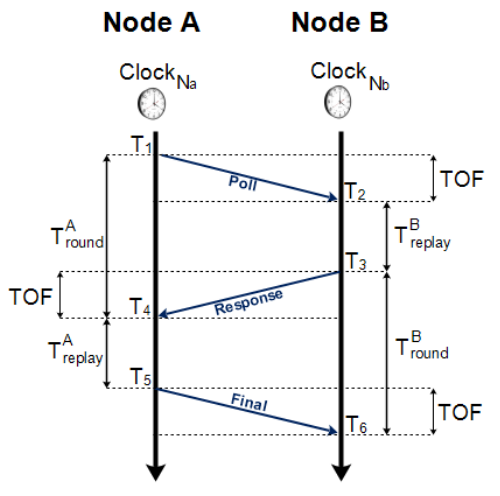
Figure 5. Symmetric double-sided two-way ranging